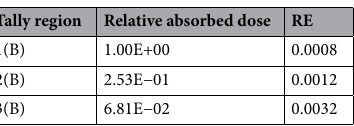
Table 7. Relative absorbed dose fraction values per unit of exposure time at the detectors of the B scenario (see Fig. 2 and Table 5 for details). RE, relative error.